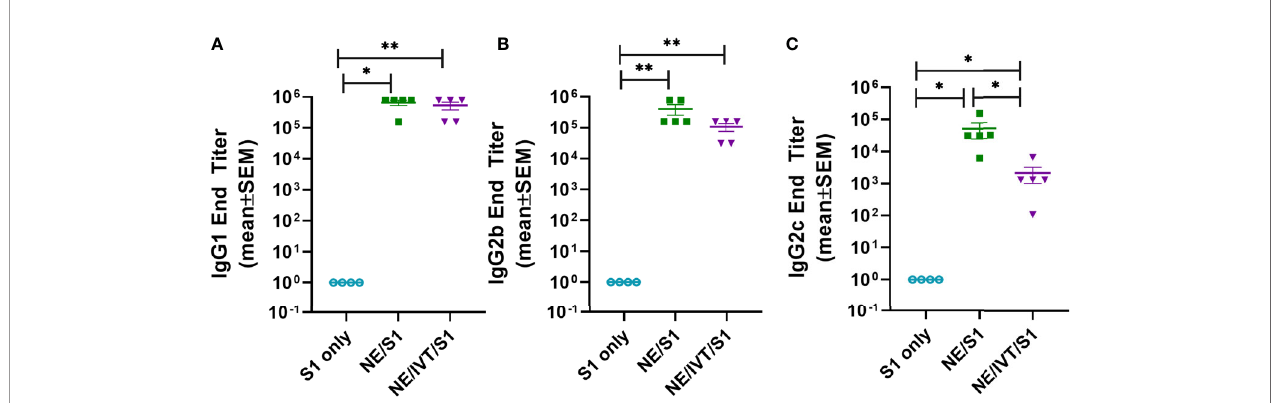
FIGURE 3 | Serum S1-speci fi c IgG subclass distributions induced by immunization. Levels of (A) IgG1, (B) IgG2b, and (C) IgG2c were measured in mice immunized IN with 15 m g S1 alone, or with 20% NE, or 20% NE/0.5 m g IVT DI after the last boost immunization, 10 wks post-initial immunization. (*p < 0.05, **p < 0.01 by Mann- Whitney U